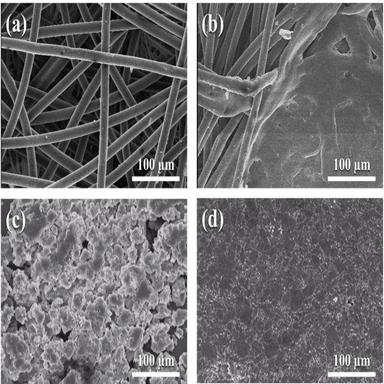
SEM images of raw WM and after different pretreatment methods: (a) raw WM; (b) WM-S; (c) WM-N; and (d) WM-TO.